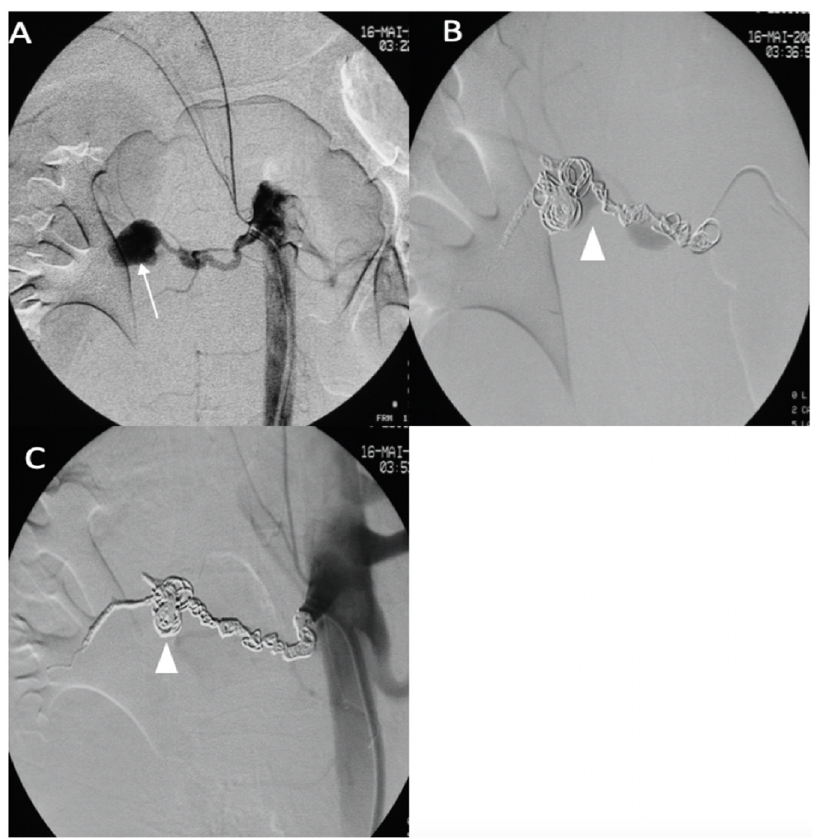
Figure 7. ( A ) Digitally subtracted image from the right renal artery revealing the distal aneurysm with irregular walls (arrow). ( B , C ) Postembolization by coils.